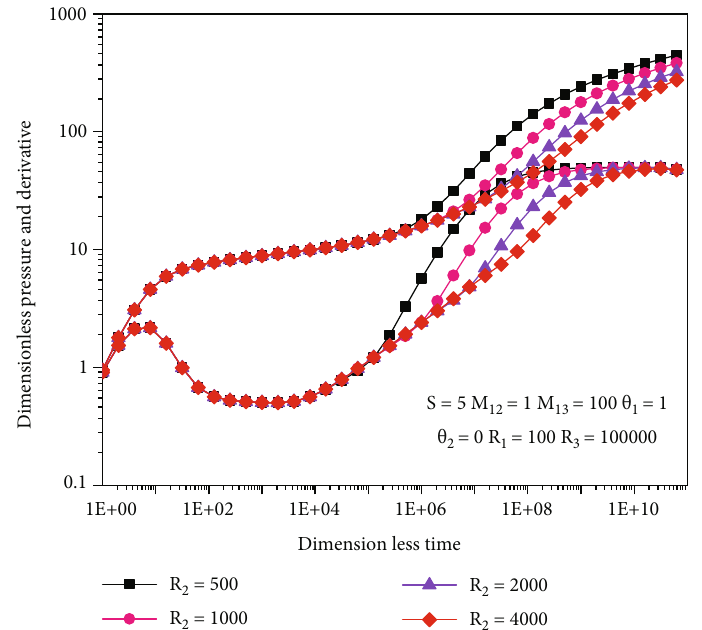
Figure 9: In fl uence of the radius of the transition zone of the three-zone homogeneous radial composite reservoir on the well bottom pressure